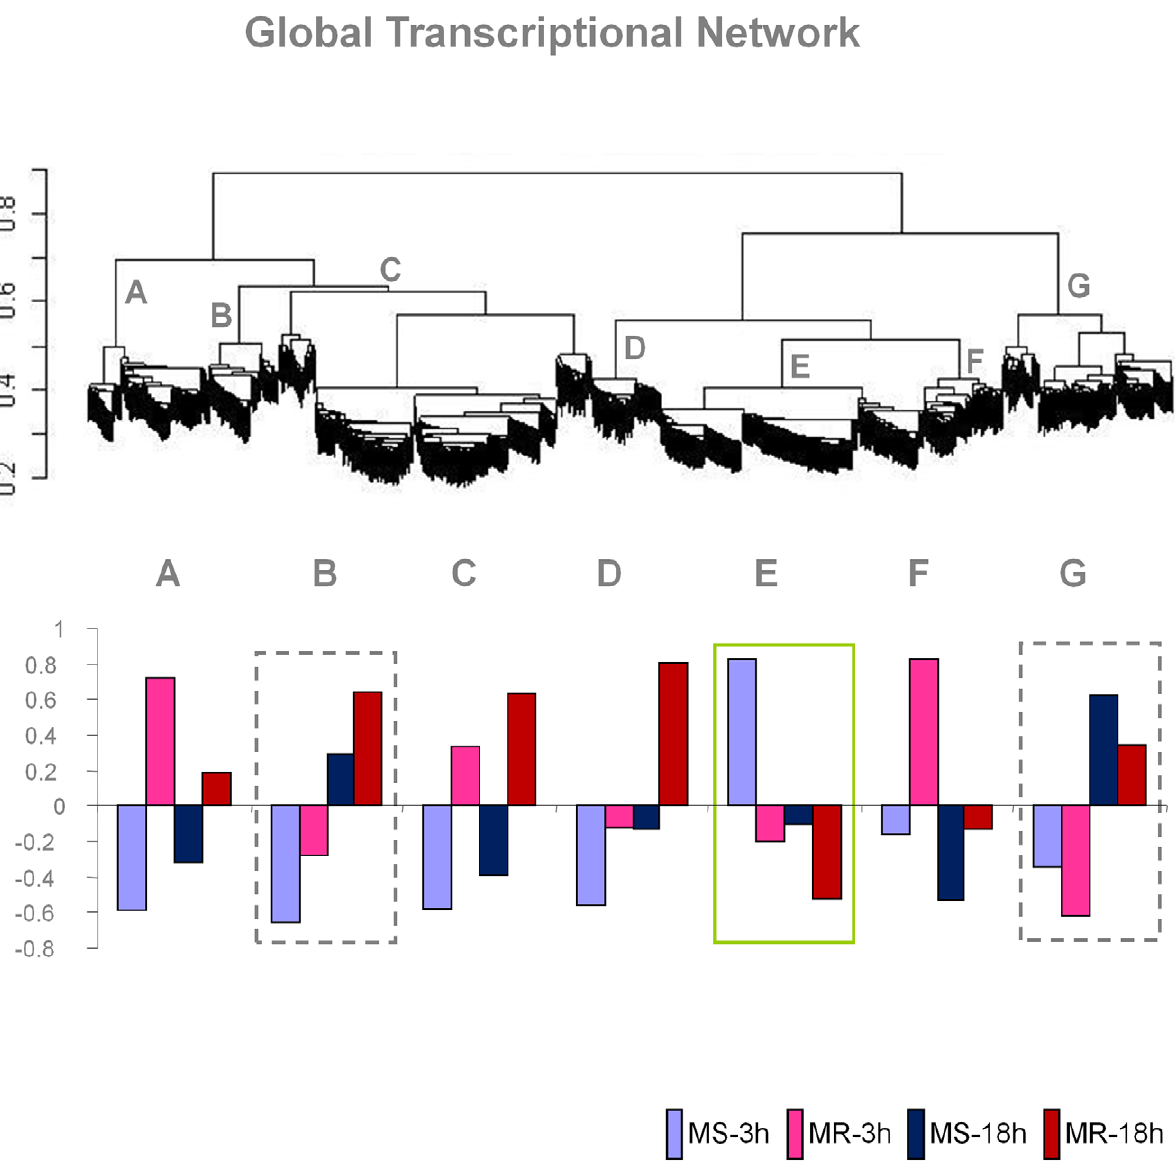
Figure 1. Modular expression patterns of Aedesaegypti genes in response to dengue virus infection. The top panel shows a WGCNA transcriptional network of host responsive genes between the susceptible (MS) and the refractory (MR) strains at 3 hr and 18 hr post-infection times, followed by dynamic hybrid cutting by topology overlapping. The scale on the left shows the branch heights. The modules are shown as ‘A’ through ‘G’. The bar graphs in the bottom panel represent the overall gene expression pattern of genes in the respective modules among the test samples. The up-regulated and down-regulated expression of genes is shown by eigengene values (module eigengene is defined as the first principal component of the expression matrix of the corresponding module) (shown in the Y-axis) for each module.